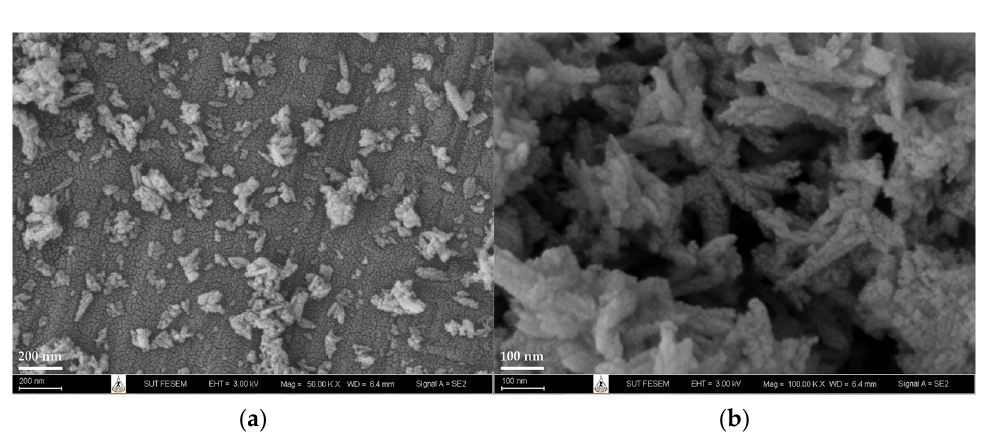
Figure 5. FE ‐ SEM images of FSp at ( a ) ×50,000 and ( b ) ×100,000